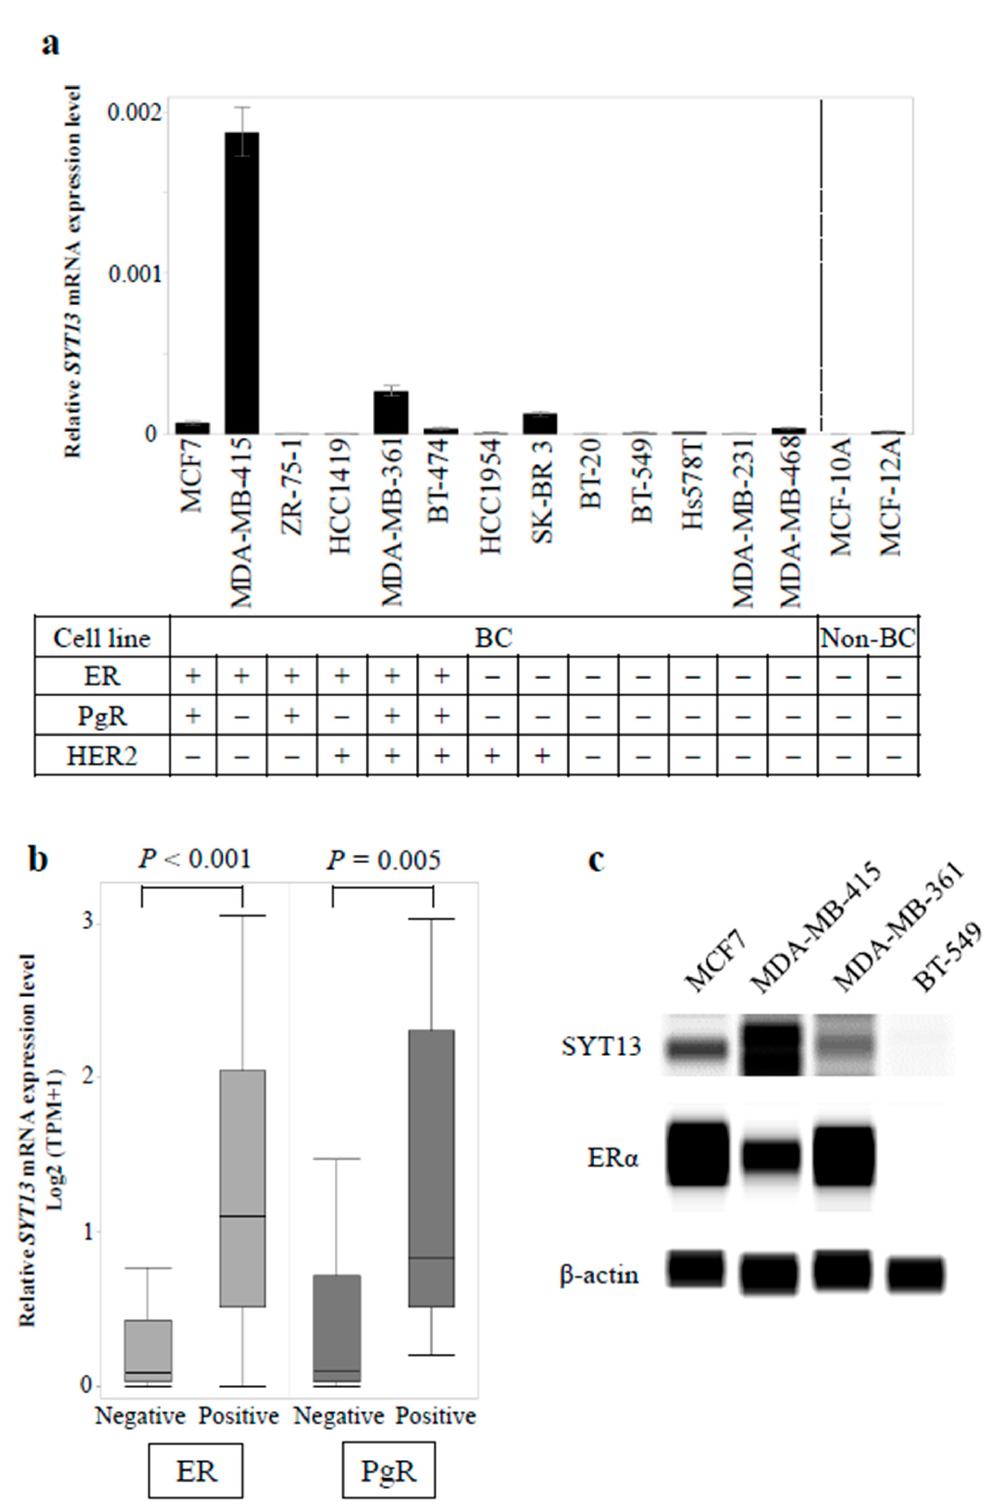
Figure 1. ( a ) Expression levels of SYT13 in breast cell lines. Bar graphs show the relative SYT13 mRNA levels in 13 BC cell lines and two non-cancerous breast cell lines. ER-positive cell lines showed significantly higher SYT13 mRNA expression levels than ER-negative cells and non-cancerous cells. ( b ) In the CCLE database, ER-positive and PgR-positive BC cell lines expressed higher SYT13 mRNA levels, compared with ER-negative and PgR-negative ones, respectively. ( c ) SYT13 protein expression in the representative BC cells. Among ER-positive cell lines, MDA-MB-415 displayed the highest SYT13 expression and SYT13 expressions in MCF7 and MDA-MB-361 cells were modest. BT-549, an ER-negative cell line, hardly expressed SYT13 or ER α . BC cells, BC cell lines; non-BC, non-cancerous cell lines; TPM, transcripts per million.